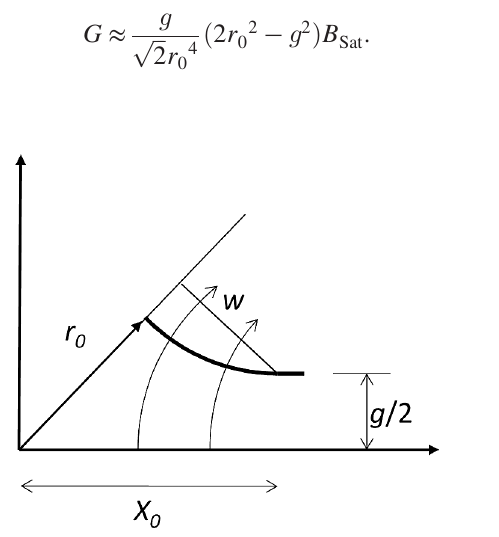
FIG. 2. Conservation of the magnetic flux across the